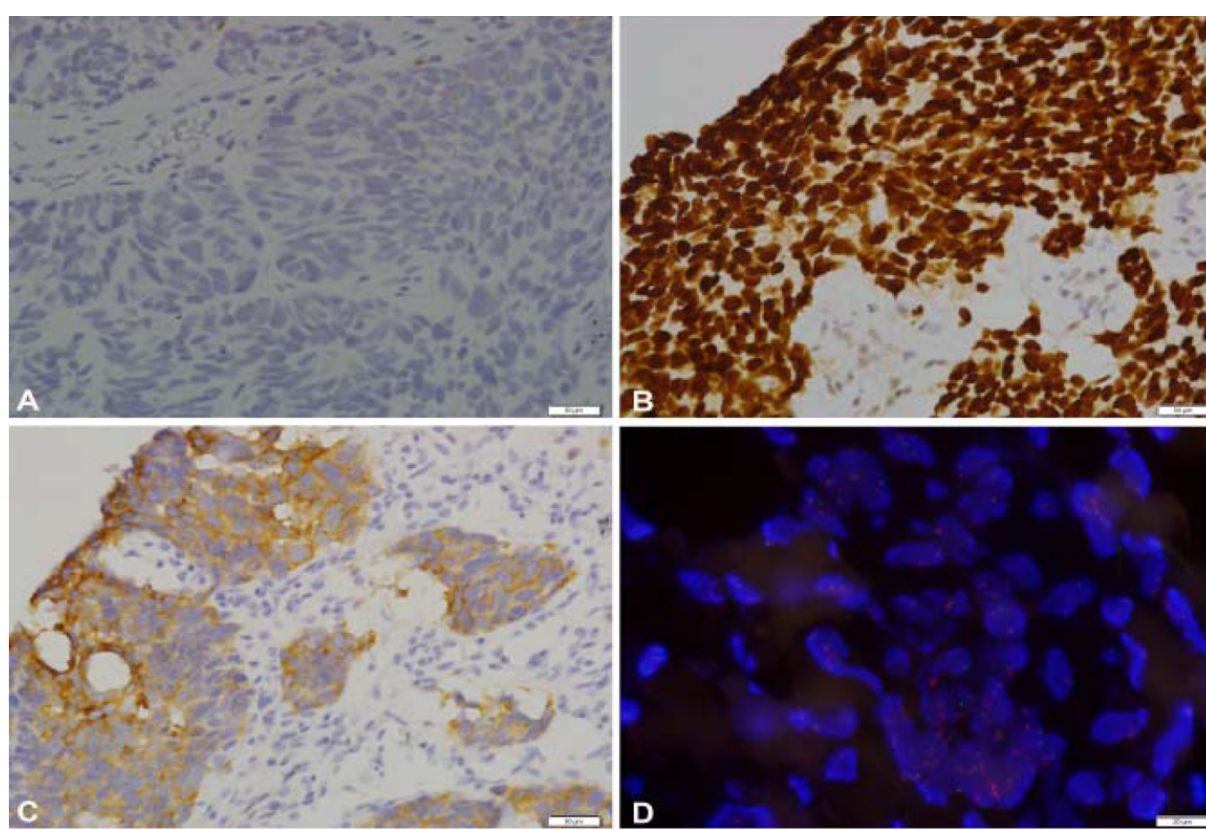
Fig. 2. Representative immunopathological features of SCLC and EGFR fluorescent in situ hybridization in the same patient in Fig. 1. (A) An echo-guided biopsy showed characteristic small round oval cells with scanty cytoplasm and fine granular nuclear chroma- tin. No adenocarcinoma components were present. Tumor cells showed strong nuclear TTF-1 immunostaining (B) and positive synaptophysin immunostaining (C). (D) Tumor cells showed one or two copies of EGFR gene (orange) (green, centromere control probe). The EGFR/CEP7 ratio is